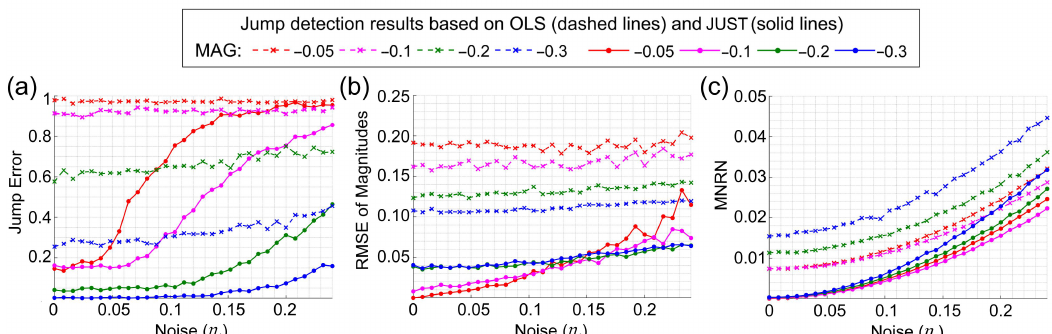
Figure 5. Statistical results for the ( a ) detection of the true jumps, ( b ) magnitudes of the true jumps, and ( c ) residual series using the OLS-based method and JUST shown by dashed and solid lines, respectively. The results are for a collection of 1000 unequally spaced two-year-long time series per each noise level.